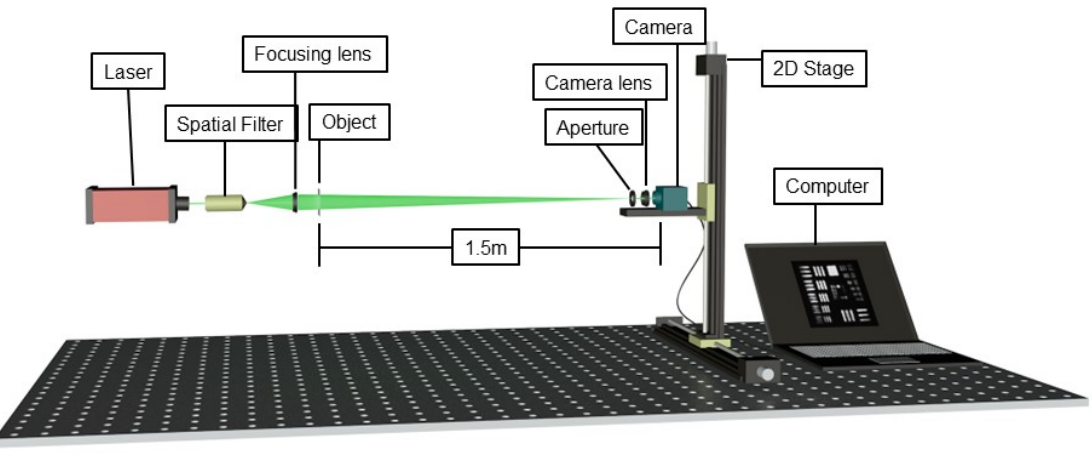
Figure 5. Schematic diagram of the experiment. From left to right: The 532 nm wavelength laser is passed through a spatial filter as a coherent light source. The focusing lens will make the transmitted light field of the object converge on the aperture plane and Fourier transform. The light field passes through an aperture of a certain size, and the lens inverse Fourier transforms the signal and focuses it onto the camera sensor. The electronically controlled high-precision displacement stage drives the camera to capture image information at different positions.